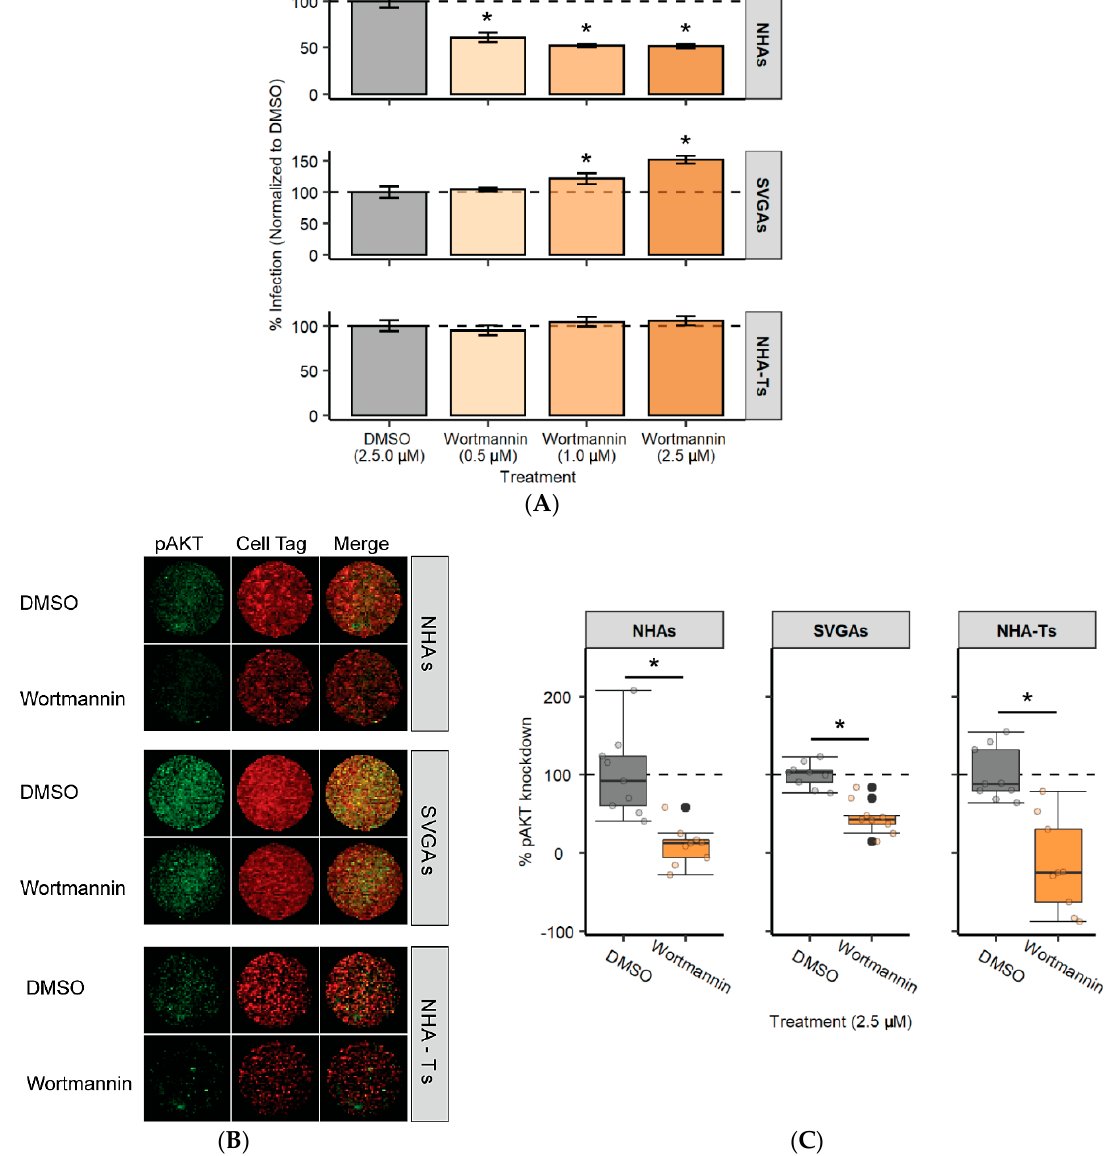
Figure 5. PI3K inhibitor wortmannin reduces JCPyV infection in NHAs. ( A ) NHAs, SVGAs, and NHA-Ts were pretreated with indicated concentrations of a PI3K inhibitor, wortmannin, or DMSO at an equivalent volume control and then infected with JCPyV (MOI = 1.0 FFU/cell) at 37 ◦ C for 1 h. Cells were incubated in media containing DMSO or wortmannin for 48 h and then fixed and stained by indirect immunofluorescence. Infectivity was determined by counting the number of JCPyV T Ag-positive nuclei divided by the number of DAPI-positive nuclei for five × 20 fields of view for triplicate samples (% infection). Data is representative of three individual experiments. Error bars indicate SD. Student’s t test was used to determine statistical significance comparing DMSO to wortmannin for each cell type. ( B ) NHAs, SVGAs, and NHA-Ts were treated with DMSO or wortmannin (2.5 µ M) at 37 ◦ C for 24 h. Cells were fixed and stained for pAKT (green) or CellTag (red). Entire wells of a 96-well plate are shown. ( C ) Percentage of pAKT for each cell type was quantitated by ICW signal intensity values per [(pAKT)/Cell Tag × 100% = % response] within each ICW analysis using LI-COR software (representative image shown in B). Box and whisker plots represent the distribution of samples (individual points) with the lower quartile, median and upper quartile denoted as black lines. The dashed line indicates the normalized DMSO % response of pAKT. Colored points represent individual points for each treatment (3 replicates, performed in triplicate), and outliers are represented by black circles. A Wilcoxon rank sum exact test was used to compare treatments in each cell type. Data are representative of three independent experiments performed in triplicate. *, p <